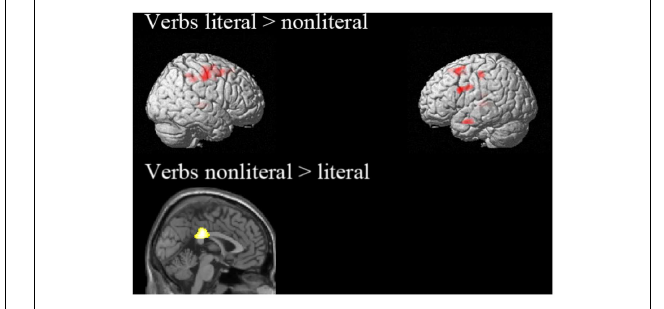
FIGUREA5 |Activation additional whole brain analyses with a less conservative threshold. All contrasts are thresholded at p < 0.001 uncorrected, cluster extent 100 voxels.